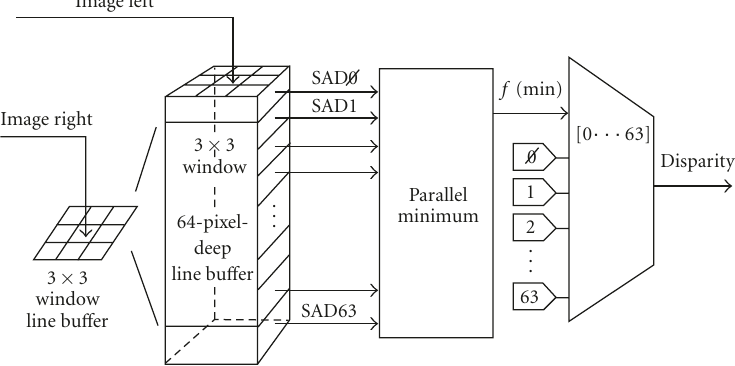
Figure 1: Parallel comparisons between 3 × 3 windows in left and right image, in a hardware implementation of the SAD algorithm.